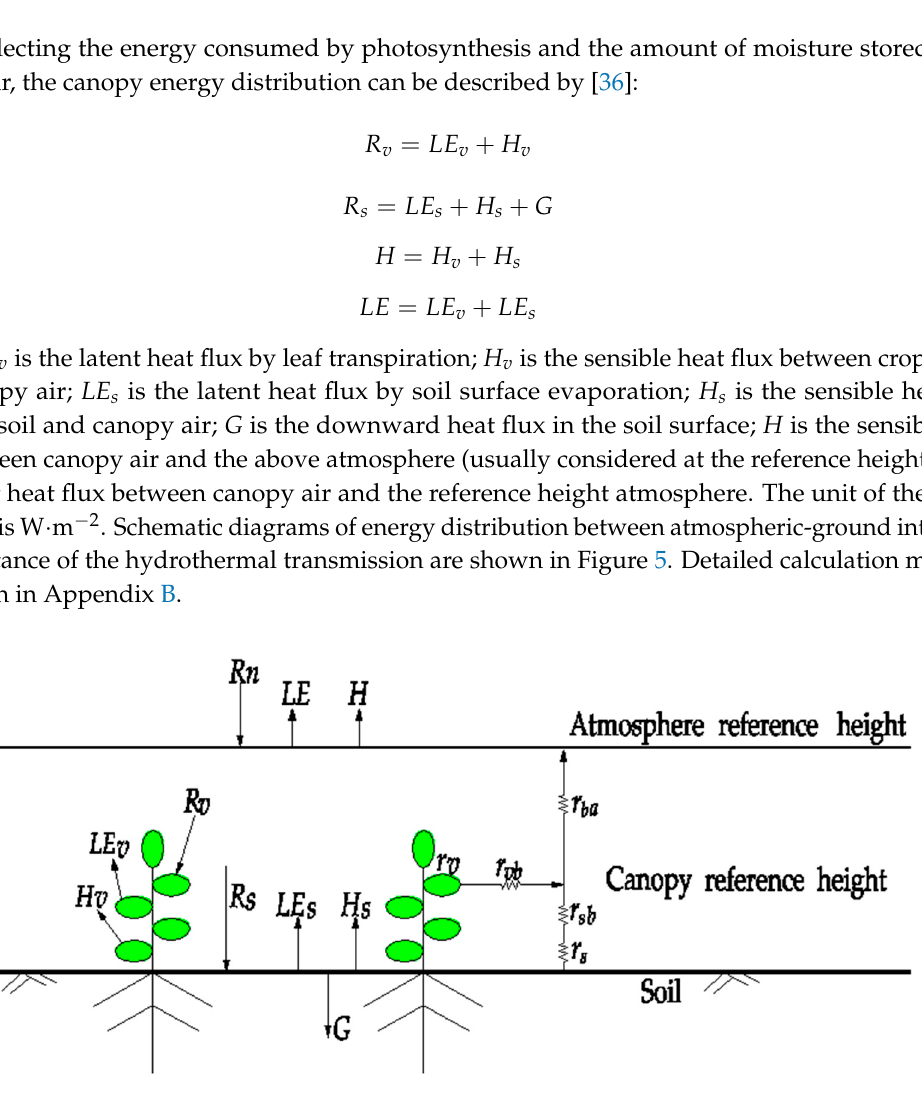
Figure 5. Schematic diagram of energy distribution in soil surface and the canopy resistance of the hydrothermal transmission.